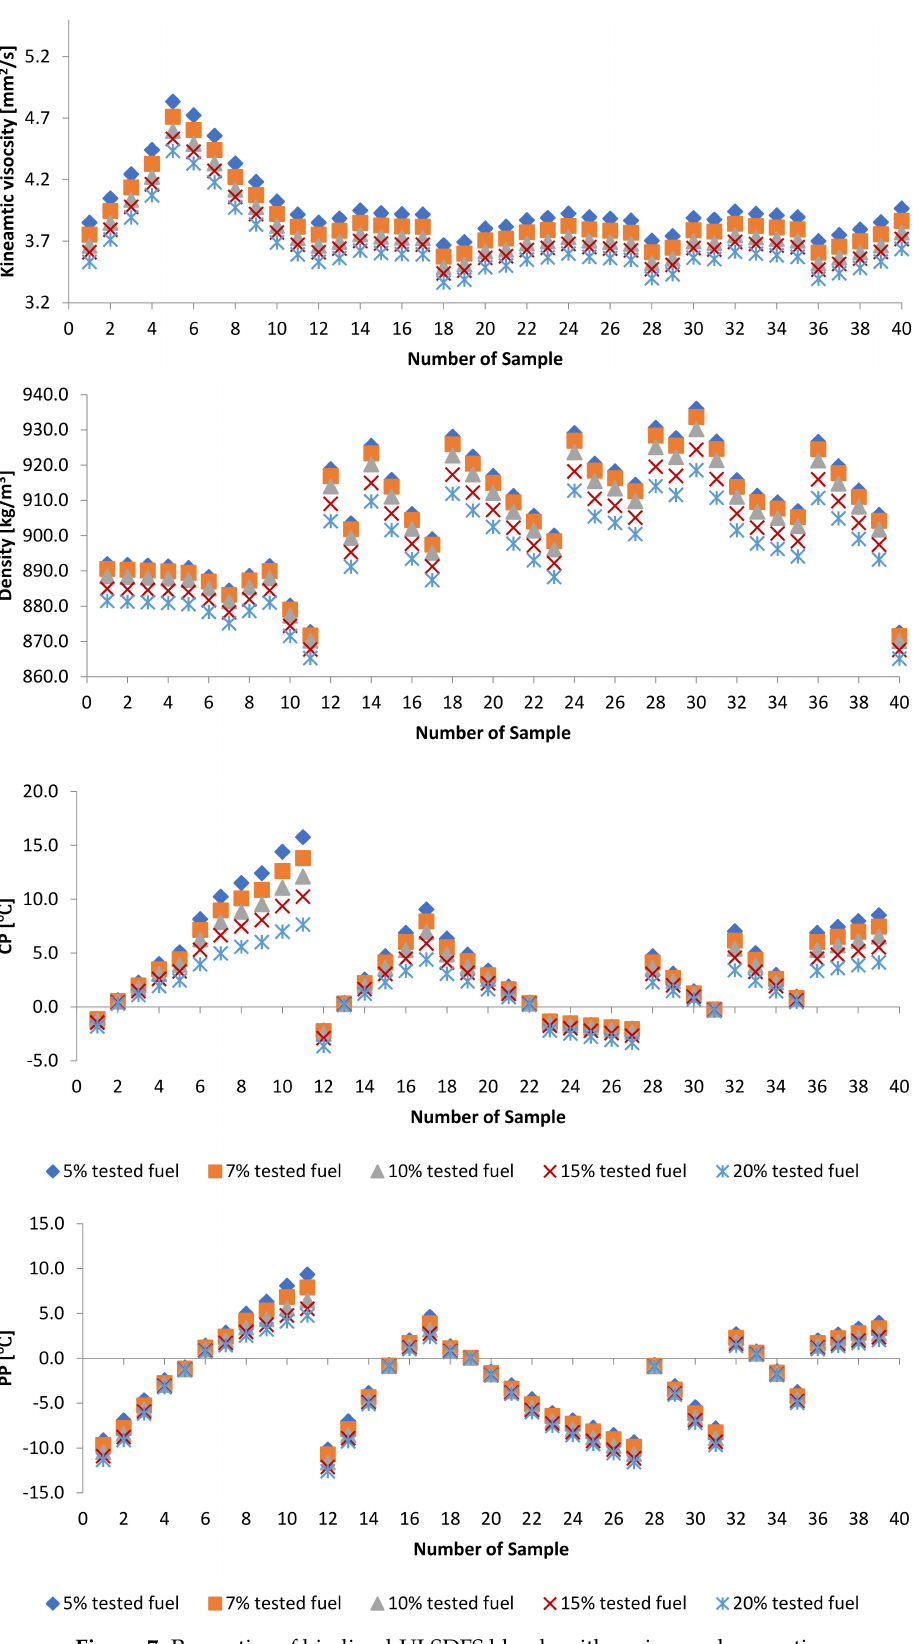
Figure 7. Properties of biodiesel-ULSDFS blends with various volume